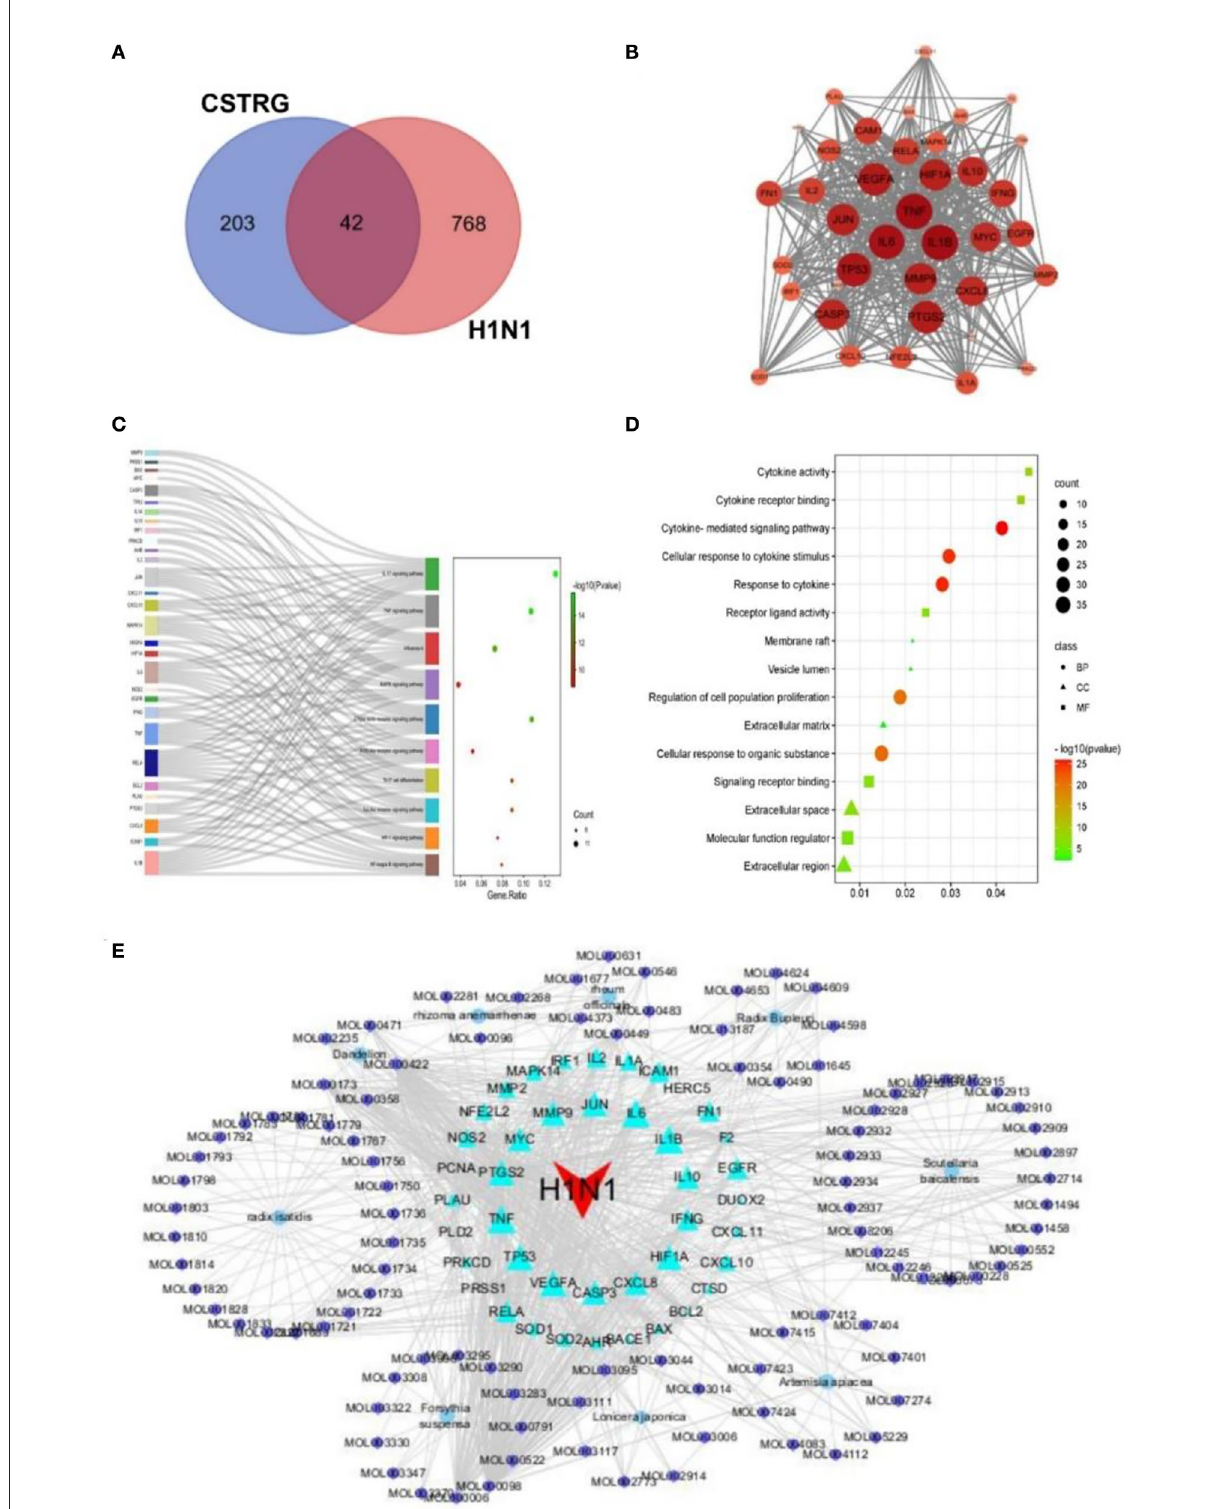
FIGURE4 (A) 42 related intersections of drug (CSTRG) targets and influenza-related targets. (B) Protein-protein interaction (PPI) networks of CSTRG components with anti-influenza activity. The nodes represent related genes, and the strength of the data is supported when the circle is